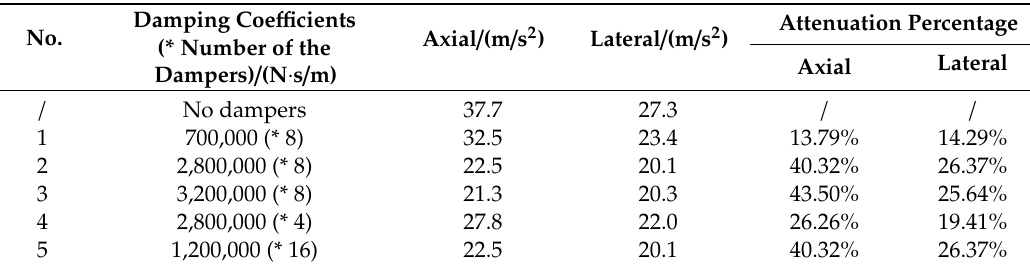
Table 2. Damping coe ffi cient designs and